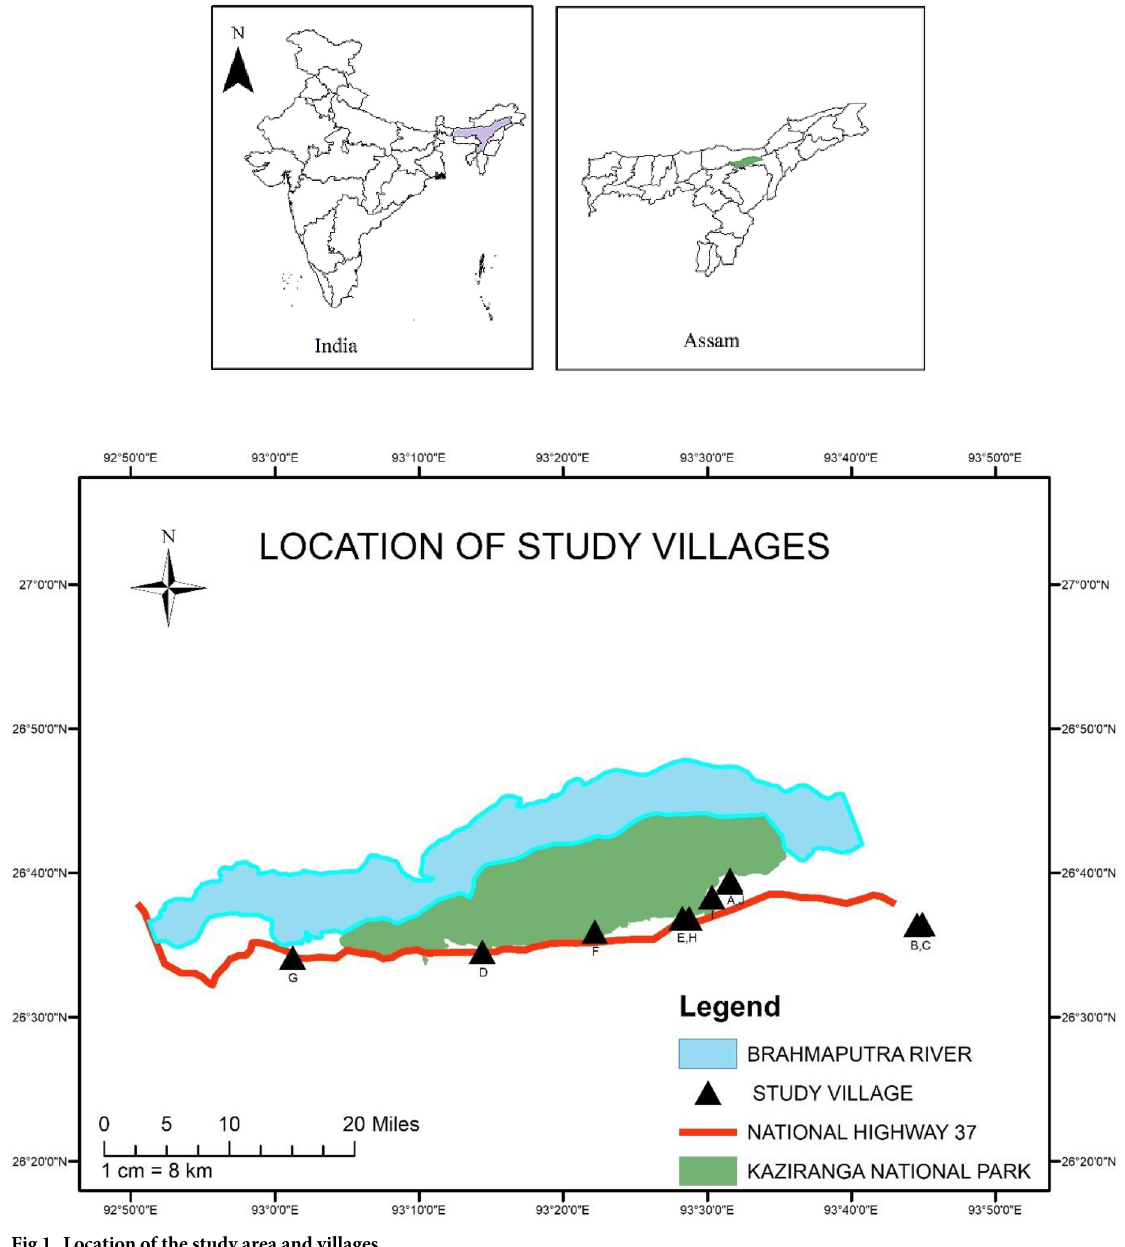
Fig 1. Location of the study area and